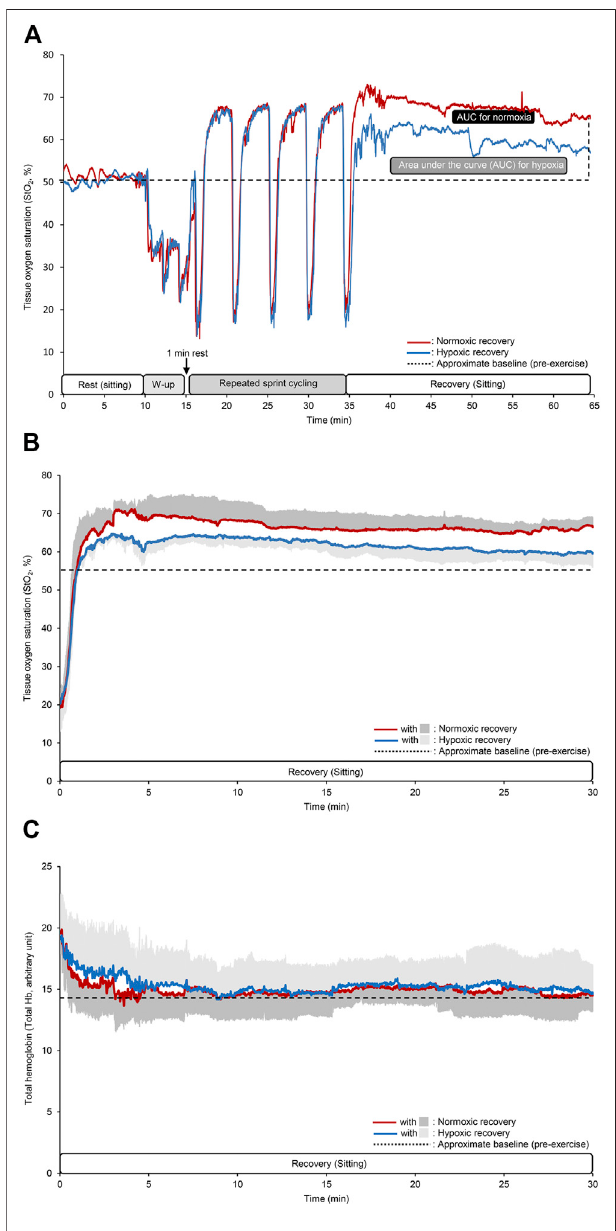
FIGURE 4 | Time course changes in the tissue oxygen saturation (StO 2 ) at the vastus lateralis muscle for a typical single subject (A) , mean values of StO 2 andtotalhemoglobin(Hb)duringtherecoveryperiod (B,C) .Thedifferent colored lines indicate the same as that in Figure 2 . In the panels (B,C) , dark and light gray areas indicate SD for normoxic and hypoxic recovery, respectively, and black dotted lines indicate approximate baseline (pre- exercise) values. Note that SD area are given only upper or lower